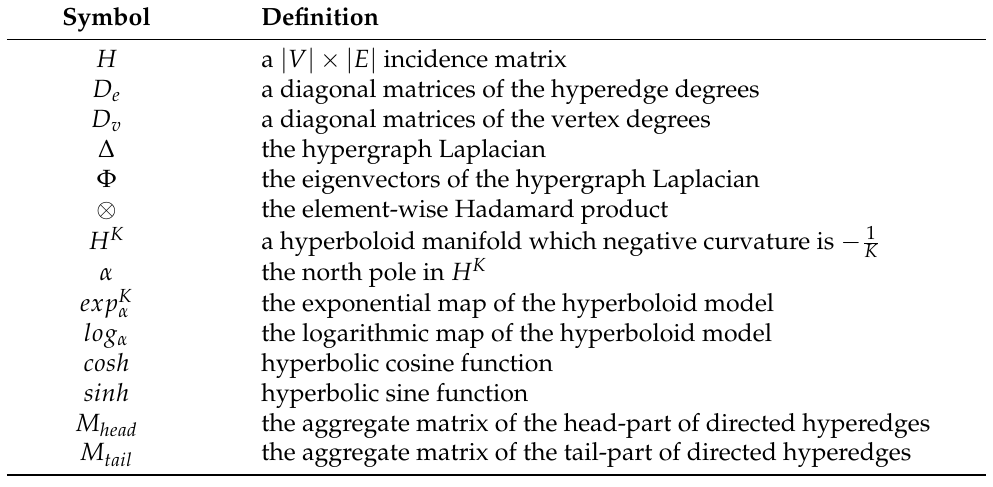
Table 1. Descriptions of notations used in the following parts.